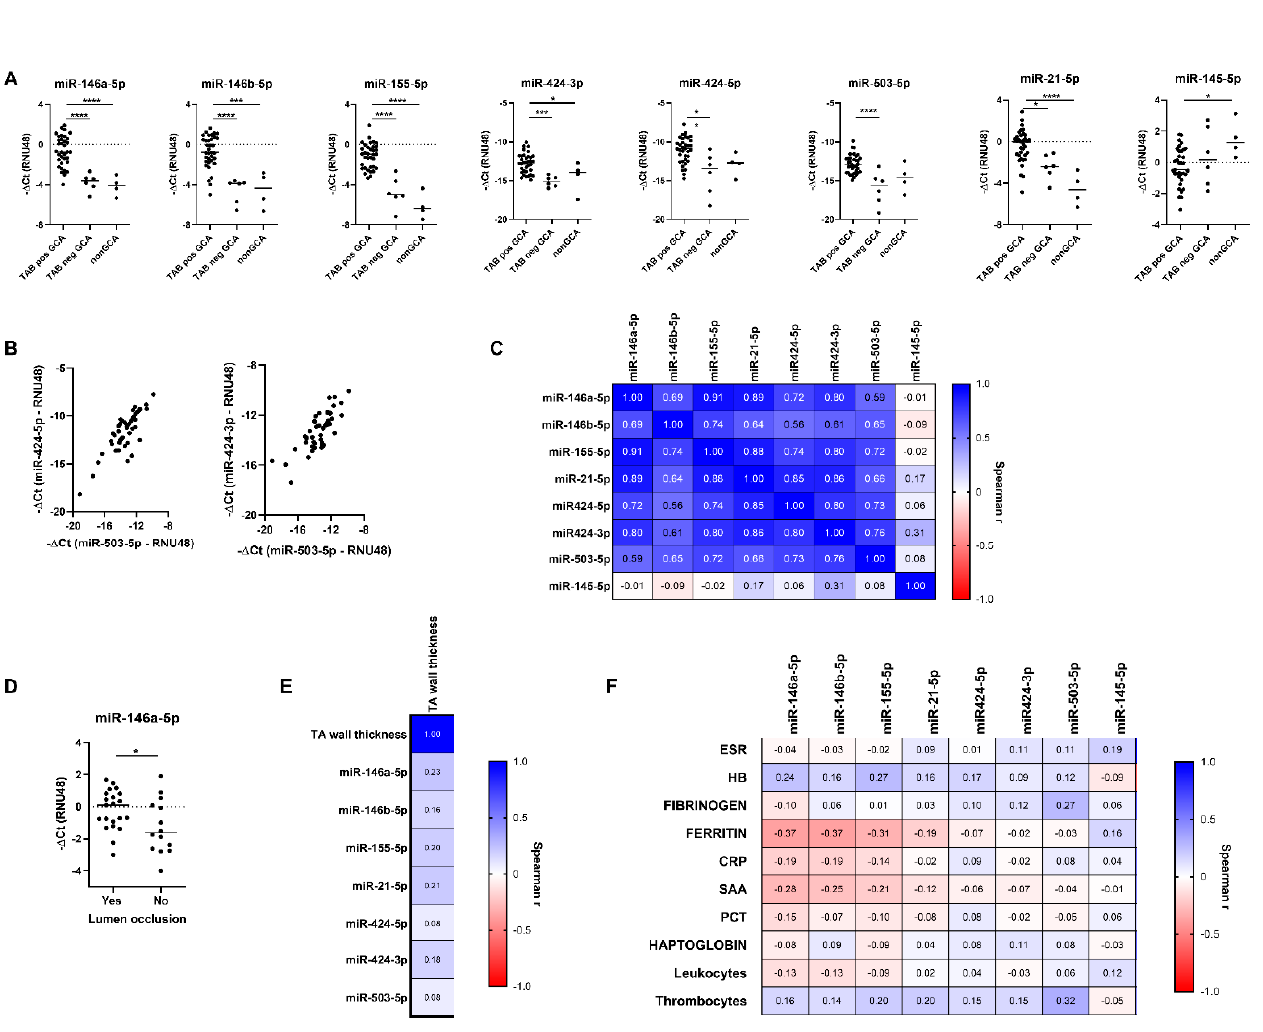
Figure 3. Deregulated expression of miR-target genes and matrixremodelling genes in TABs from GCA patients. ( A , B ) Differentially expressed ( A ) miR-target genes (see also Supplementary Table S3) and ( B ) matrix-remodelling genes in histologically positive GCA TABs ( n = 35), histologically negative GCA TABs ( n = 6) and nonGCA TABs ( n = 4). Gene expression was calculated as negative delta Ct ( − ∆ Ct) of individual mRNAs normalized to GAPDH expression. Line represents the median mRNA expression in each patient group. Values for GCA patients with negative TABs are marked with red. ( C ) Matrix of Spearman’s rank correlation coefficients between normalized expression of miR-target genes and matrix-remodelling genes across GCA ( n = 40) and nonGCA ( n = 4) TABs. Plotted are mRNAs that were identified as deregulated in GCA TABs. p values of the correlations are provided in the Supplementary Table S2. ( D ) STRING enrichment analysis of functional and physical protein-protein networks of deregulated mRNAs in GCA TABs using the medium confidence 0.400 for the minimimum required interaction score. Colour symbols indicate GCA-relevant GO biological processes that were among the most significantly enriched (FDR < 0.05). ( E ) Normalized expression of miR-target genes and matrix-remodelling genes in histologically positive GCA TABs with or without temporal artery lumen occlusion. ( F ) Highly interrelated expression of deregulated miRs, miR-target genes and matrix-remodelling genes in temporal arteries from GCA ( n = 40) subjects. Matrix of Spearman’s rank correlation coefficients between normalized expression of miRs, miR-target genes and matrix-remodelling genes across GCA ( n = 40) and nonGCA ( n = 4) TABs. Plotted are miRs and mRNAs that were identified as deregulated in GCA TABs. Correlative analyses are based on Sperman’s correlation coefficients with p < 0.05 considered as statistically significant. p values of the correlations are provided in the Supplementary Table S1. * p < 0.05; *** p < 0.001; **** p < 0.0001. Legend: YAP1, Yes-associated protein 1; PELI1, Pellino E3 ubiquitin protein ligase 1; KLF4, Kruppel-like factor 4; VEGFA, vascular endothelial growth factor A; FGF2, fibroblast growth factor 2; TIMP, tissue inhibitor of matrix metalloproteinase; MMP, matrix metalloproteinase; CRP, C-reactive protein; ESR, erythrocyte sedimentation rate; GCA, giant cell arteritis; HB, heamoglobin; mRNA, messenger RNA; miR, microRNA; PCT, procalcitonin; SAA, serum amyloid A; TA, temporal artery; TAB, temporal artery